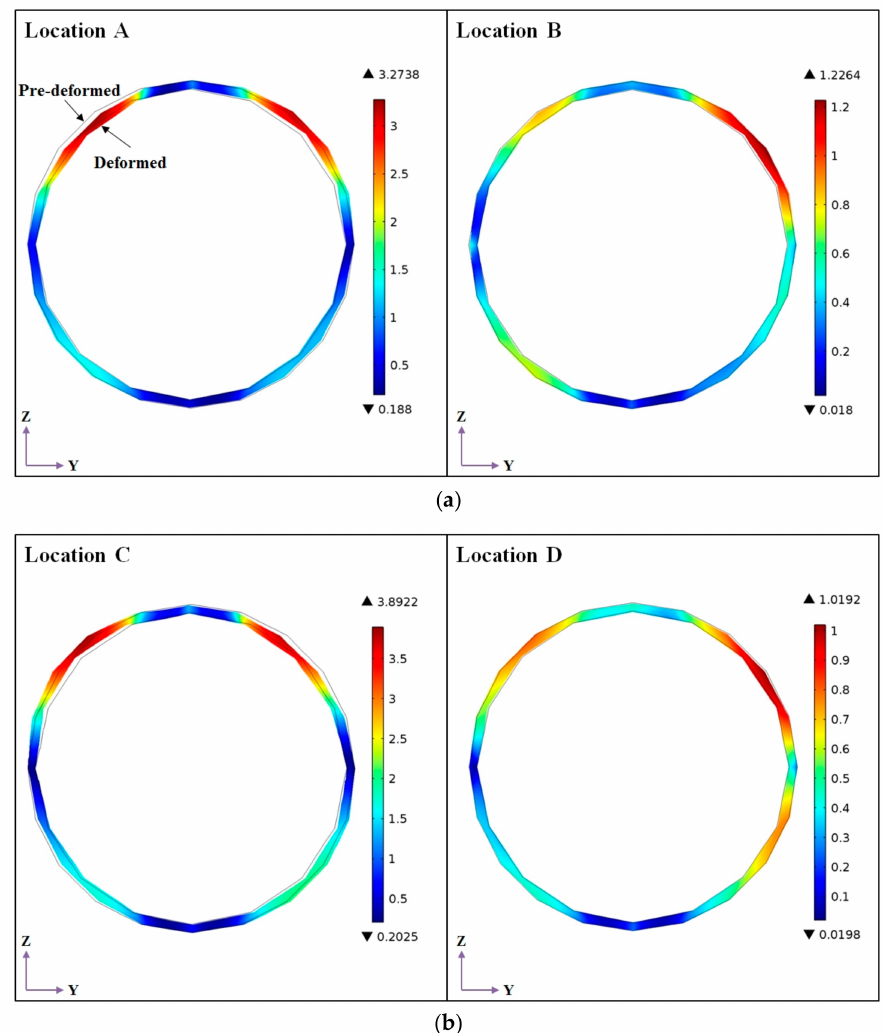
Figure 6. Contour plots ( YZ plane) of wall deformation (nm) of microalgal cells in a raceway pond with AR = 10 at a water depth of 0.2 m and rotational speed of 20 (rpm). ( a ) locations A and B ; ( b ) locations C and D